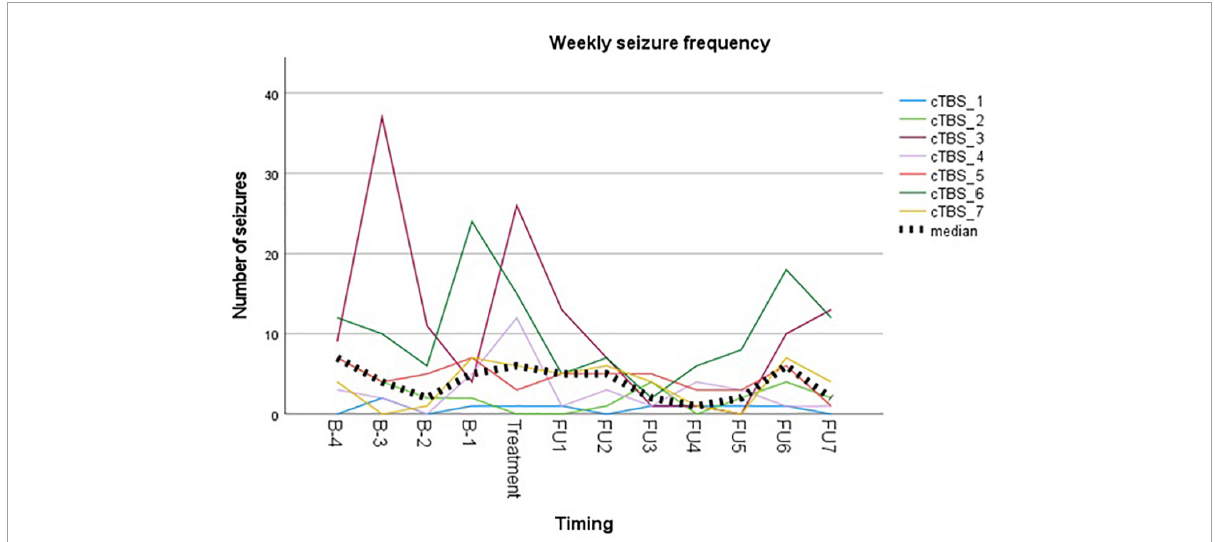
FIGURE3 Visual representation of weekly seizure frequency. Colored lines represent weekly seizure frequency per subject. Bold dotted line represents the median group value.